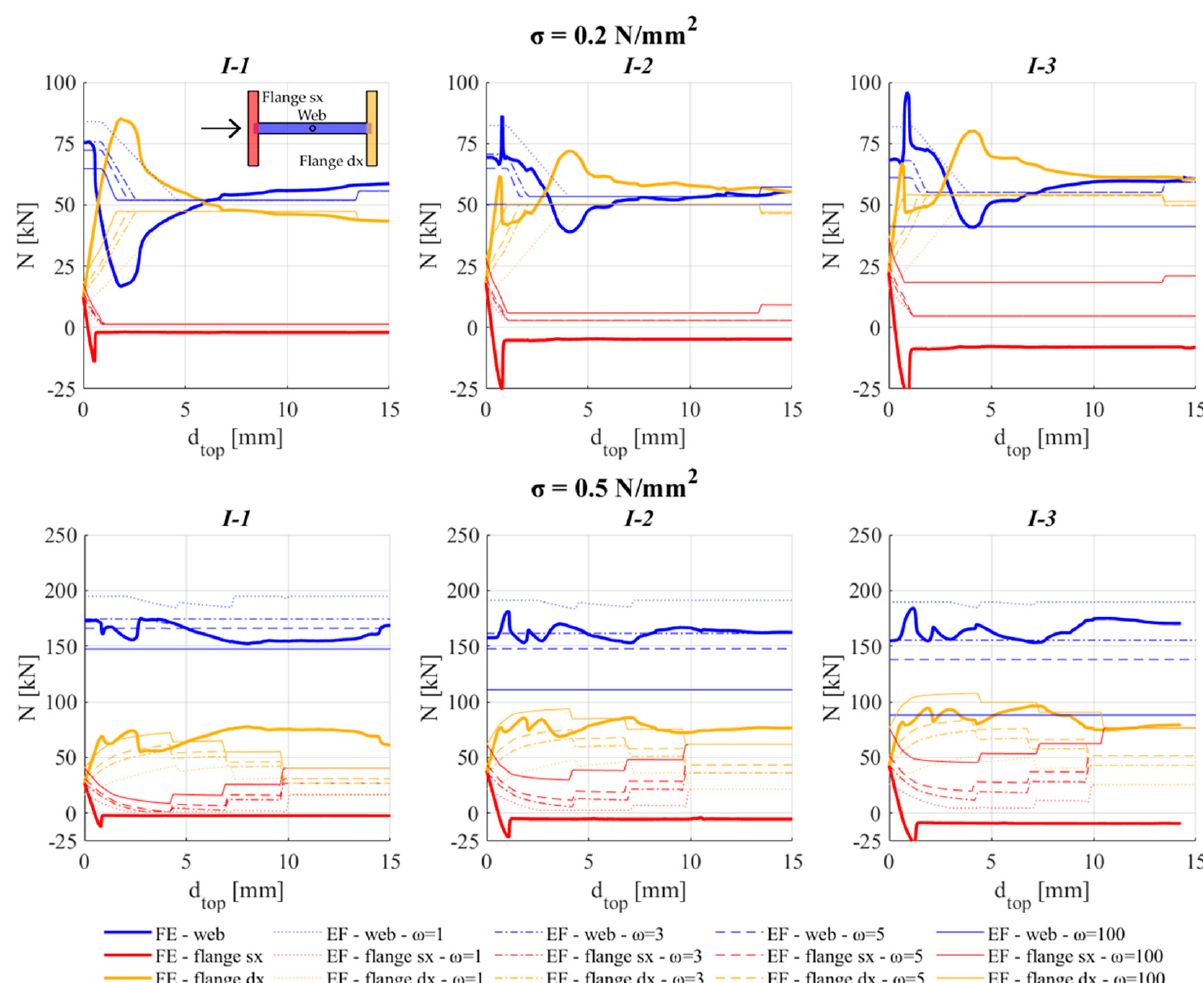
Figure 12. Comparison between FE and EF models in terms of variation of the axial loads on the web and the flanges of I-shaped 3D assembly.